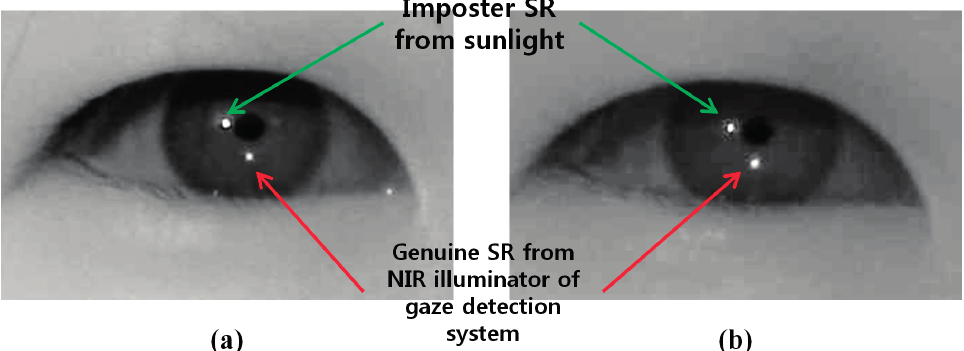
Figure 3. Eye region image under sunlight illumination ( a ) using LPF ( b ) using